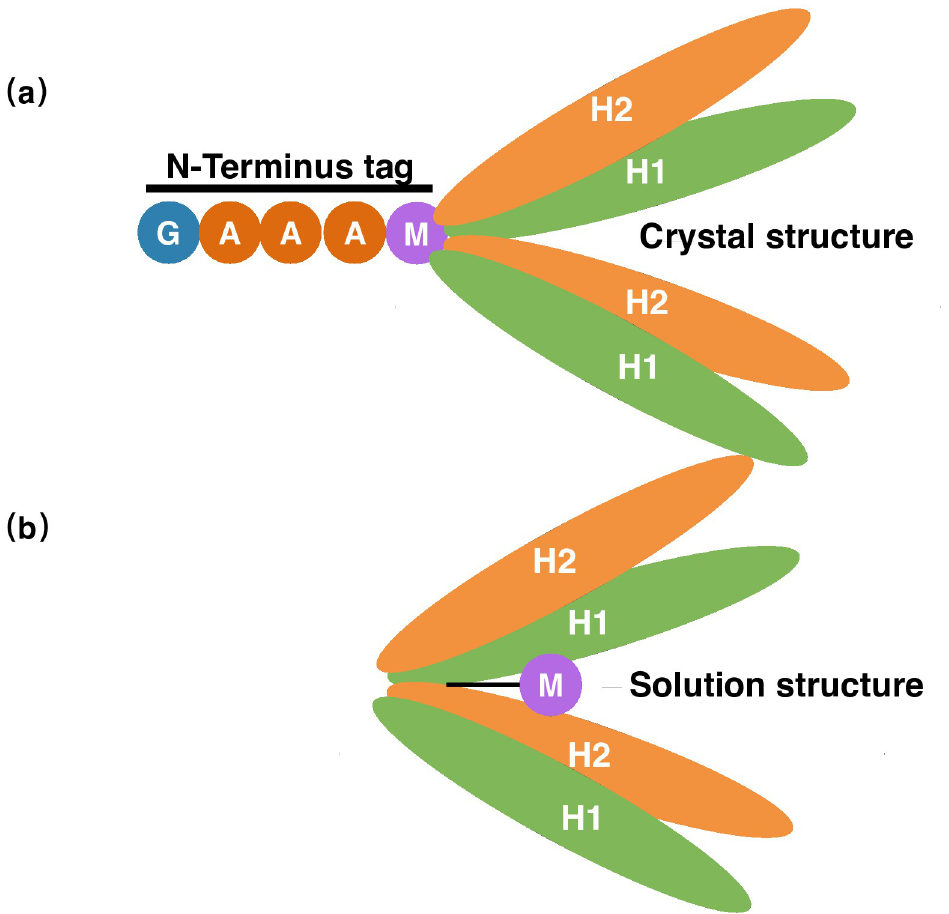
Fig 11. Schematic diagram of full-length PRC1 (a) crystal and (b) solution structure.